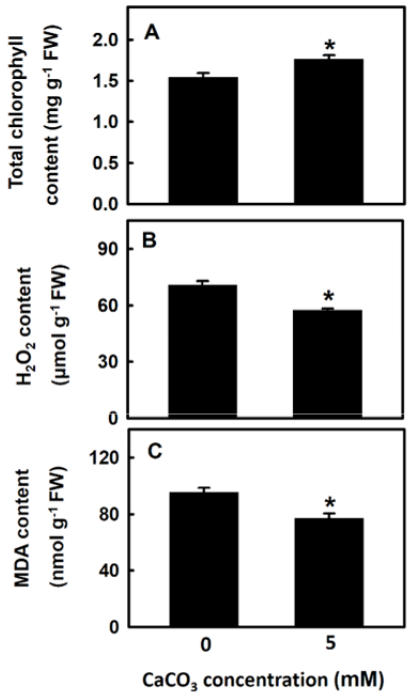
Figure 3. The effect of calcium carbonate on the physiological indictors of Djulis sprouts. The 7-d-old djulis plants were treated with 5 mM CaCO 3 for 5 days. The total chlorophyll content ( A ) H 2 O 2 content ( B ) and MDA content ( C ) of djulis were measured. Bars show means ± SE ( n = 4). * represent values that are significantly different between calcium carbonate concentration 0 mM and 5 mM at p < 0.05.